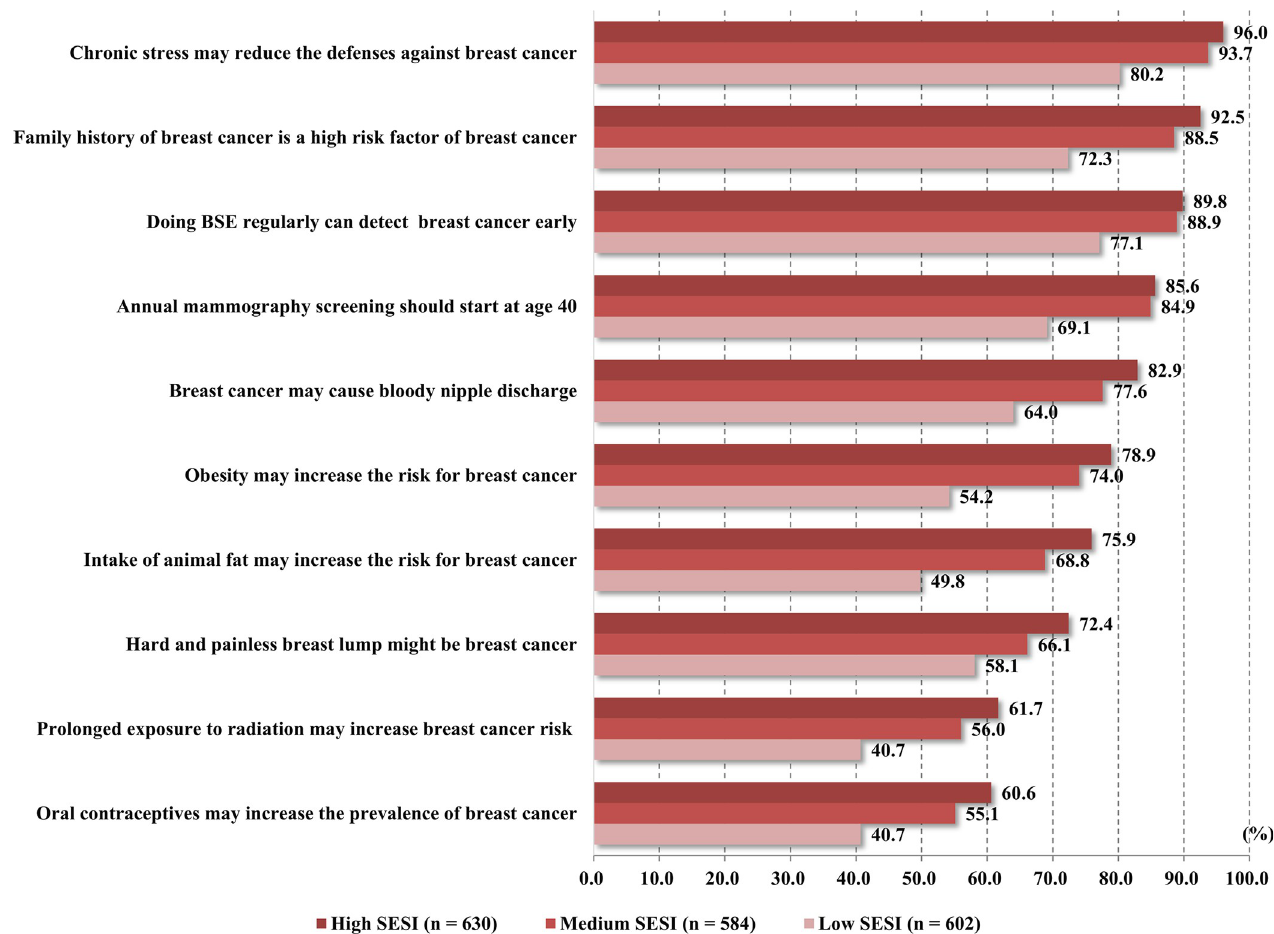
Fig 2. Proportion of correct responses for breast cancer knowledge (n = 1816). SESI, socioeconomic status index.